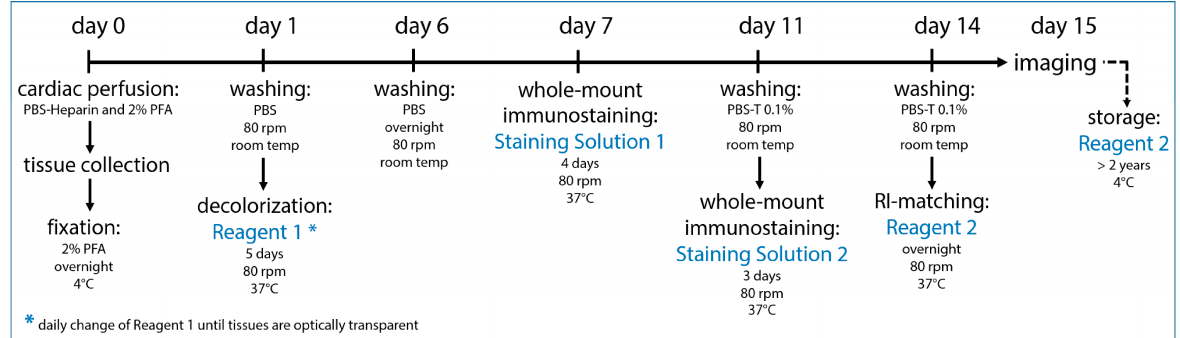
Figure 2. Optimized tissue-clearing protocol. Our optimized tissue-clearing protocol consists of an antibodies and RI-matching before the sample is ready for imaging on day 15. Samples can be stored long-term at 4 ◦ C in Reagent